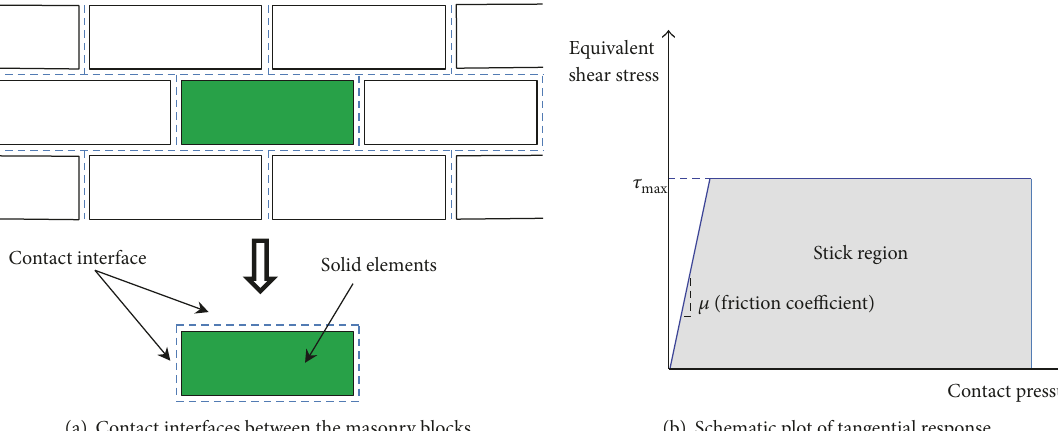
Figure 5: Contact behavior and